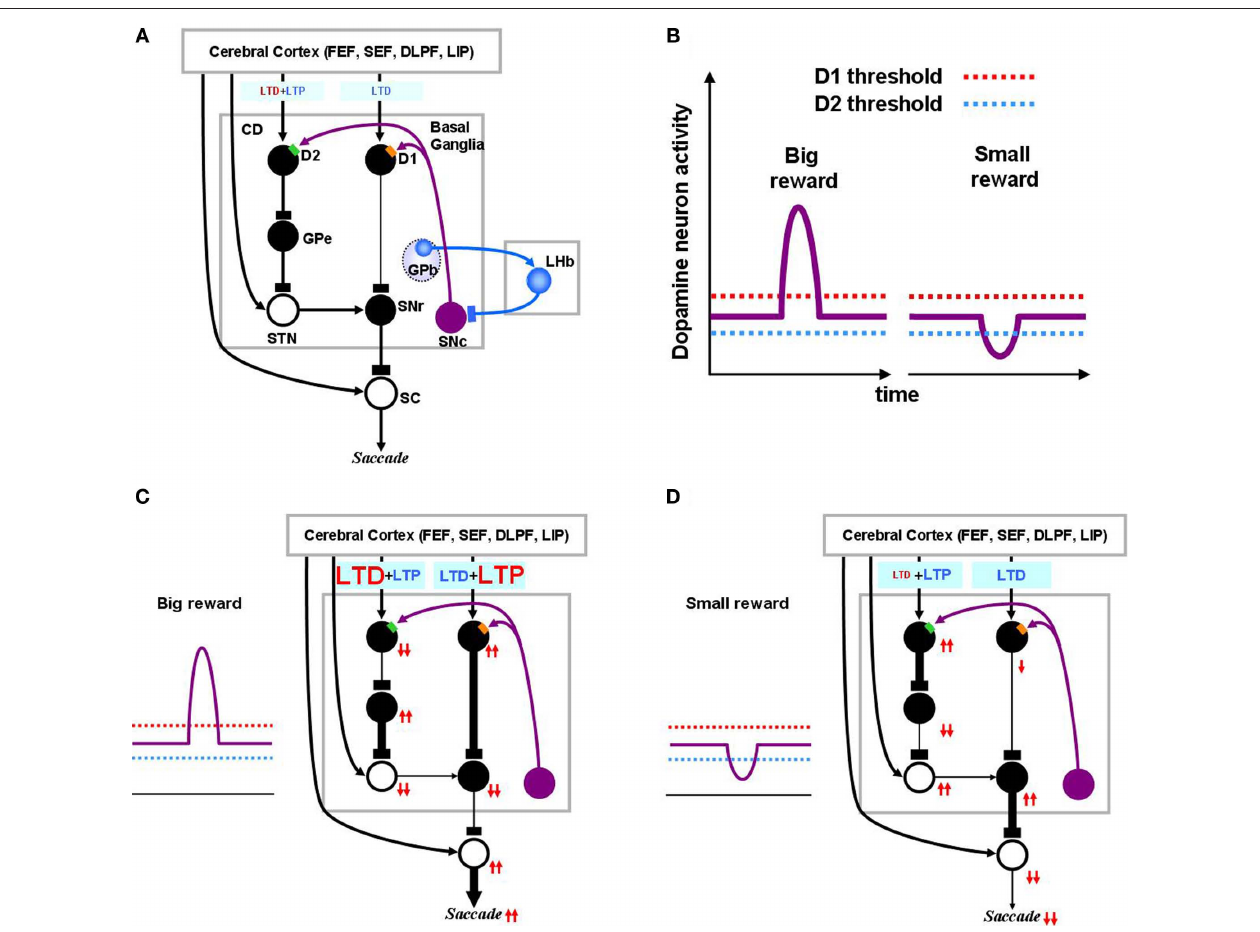
eligibility traces in Eqs 6–8). In both cases (C and D) DA-independent LTD in the direct pathway and DA-independent LTP in the indirect pathway remain unchanged, but their effects become relatively weak in big-reward trials (C) and relatively strong in no-reward trials (D) . The red arrows indicate the amplitudes (large: 2 arrows, small: 1 arrow) and directions (up, down) of the change of neural activity compared to the null state shown in (A) . Note, that even though the DA level in figure (A) and (D) are both under the threshold, LTD in the case of figure (D) happens more vigorously because of enabled eligibility (Eqs 6–8). The thickness of the connections indicates the resulting output in each module. Black and open circles indicate inhibitory and excitatory neurons, respectively. In (C) and (D) , the GPb–LHb–SNc circuit is omitted for clarity. LTP/LTD, long-term potentiation/depression; GPb, border region of globus pallidus; LHb, lateral